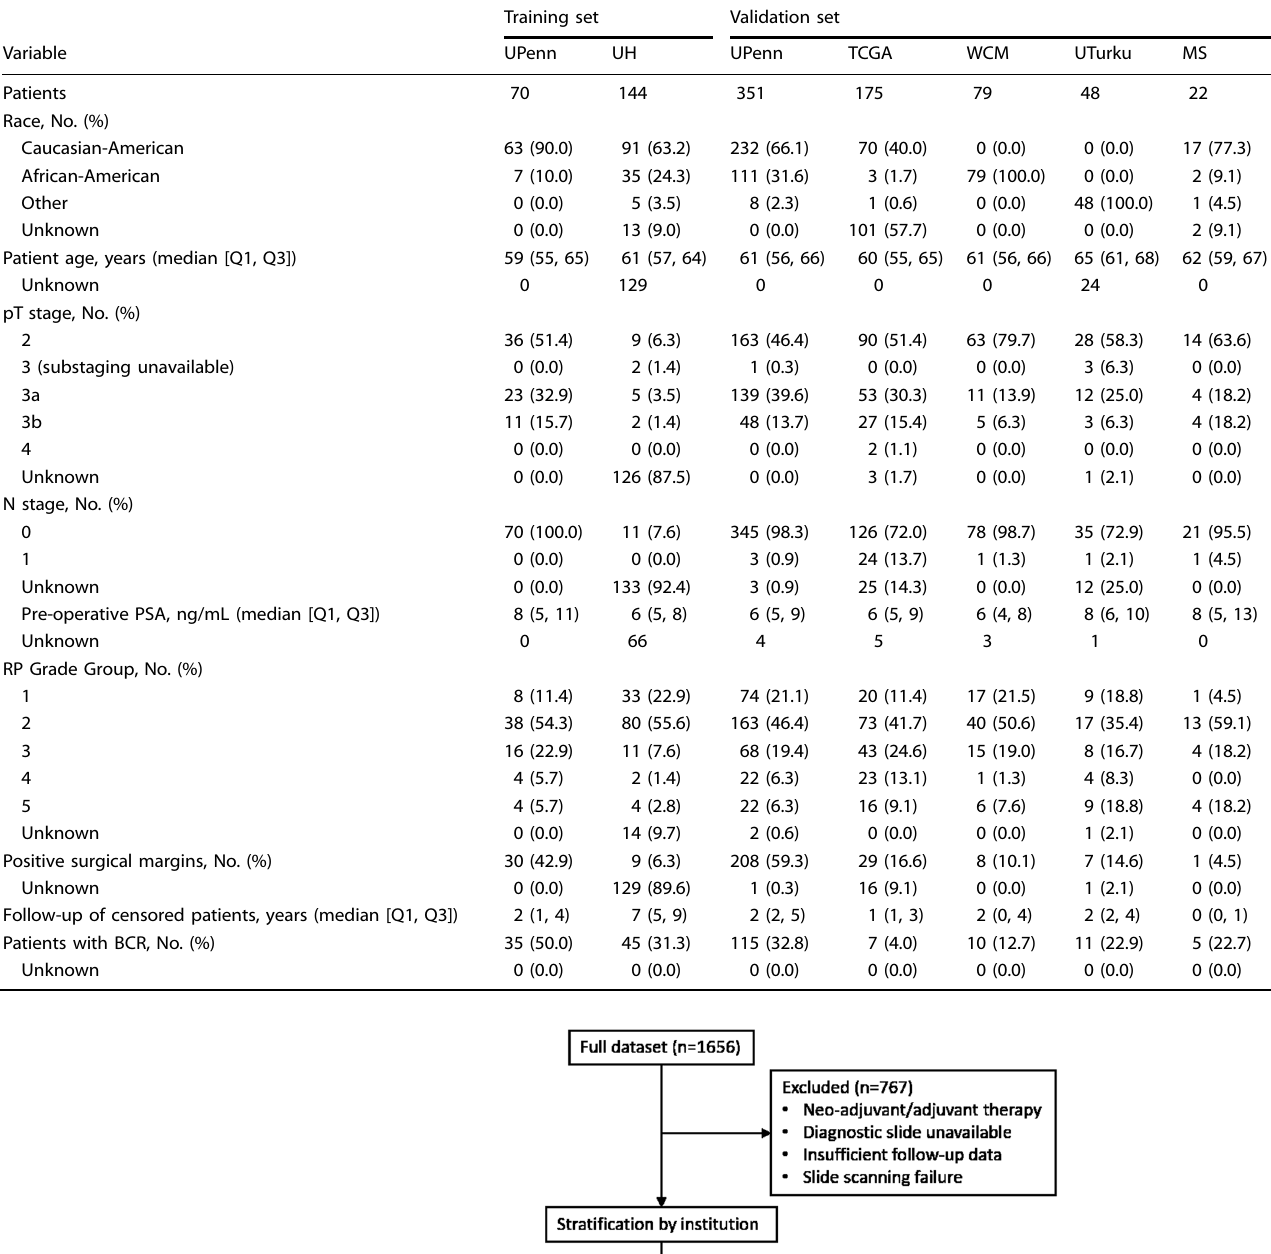
Training set Validation set